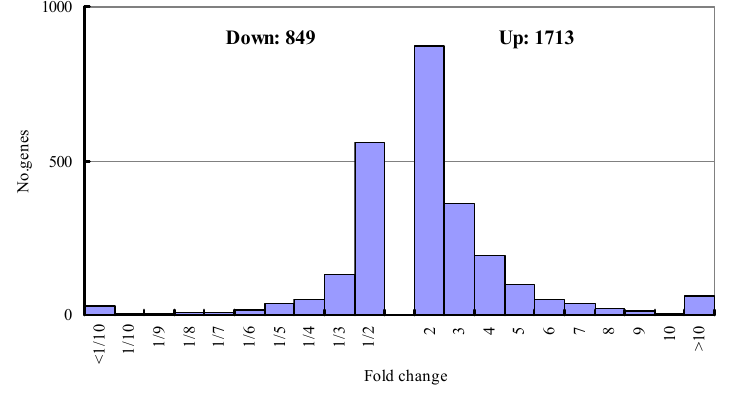
Figure 1. Distribution of genes according to the expression change in response to salt